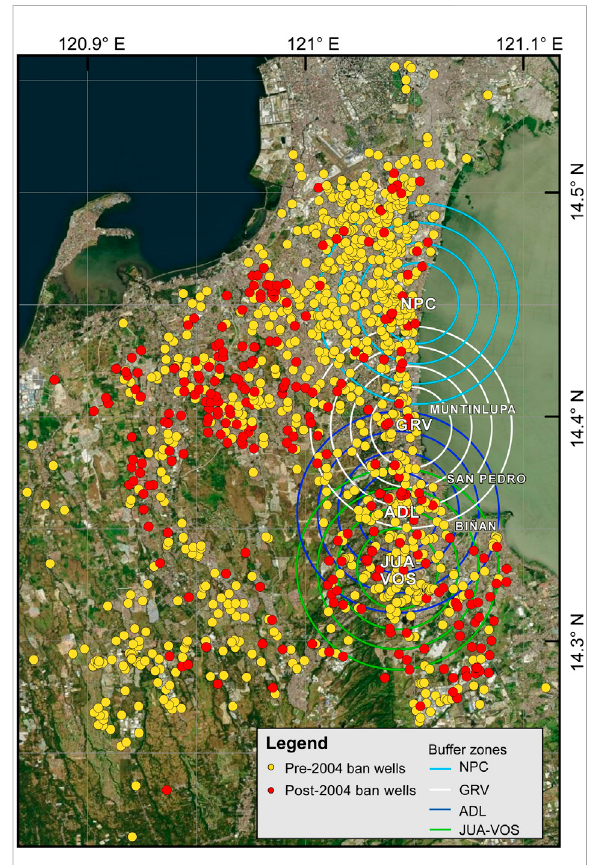
FIGURE 5 Location ofwells inthevicinityofthesurveysites.Around the survey sites are 2, 3, 4, and 5 km buffer zones drawn for purposes of determining the correlation of displacement and groundwater extraction from wells around the sites. The wells shown include all those with NWRB licenses granted from 1977 to 2019 (August). Solid yellow dots are wells with operation licenses granted before the ban on new wells (through NWRB Resolution No. 001 – 0904) on 22 September 2004. Solid red dots are wells with operation licenses granted after this date. Due to the close proximity of VOS and JUA, common buffer zones centered between the two sites were drawn. The satellite image of the survey sites is from Microsoft Bing Maps (https://www.bing.com/